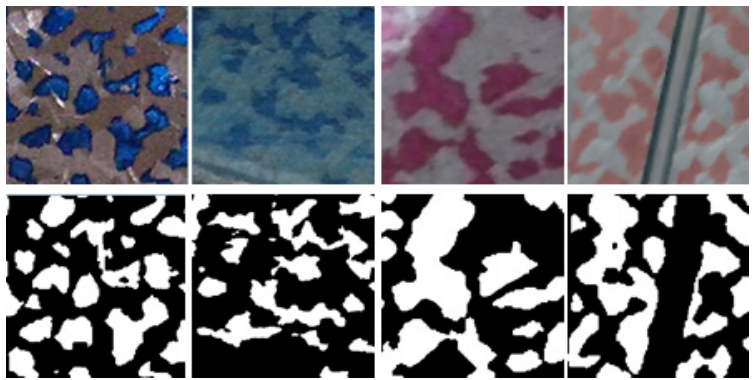
Figure 2. Example results of our network performing HOP segmentation ( down ) on scraping workpieces ( top ) and images are captured by iPhone 11.